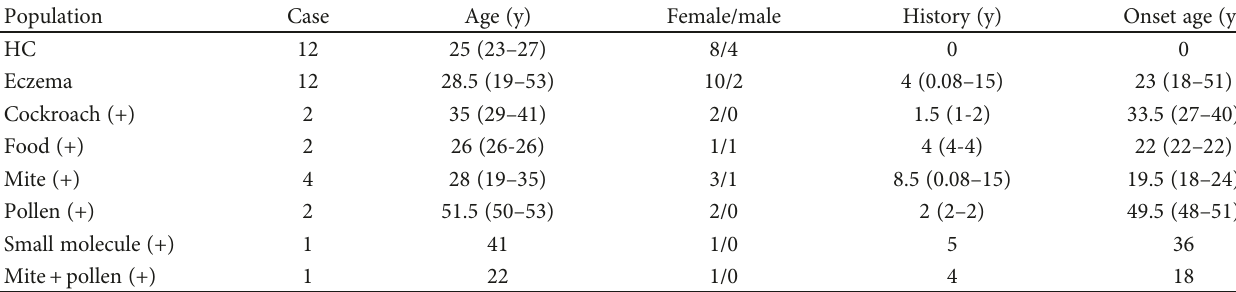
Table 1: Characteristics of adult